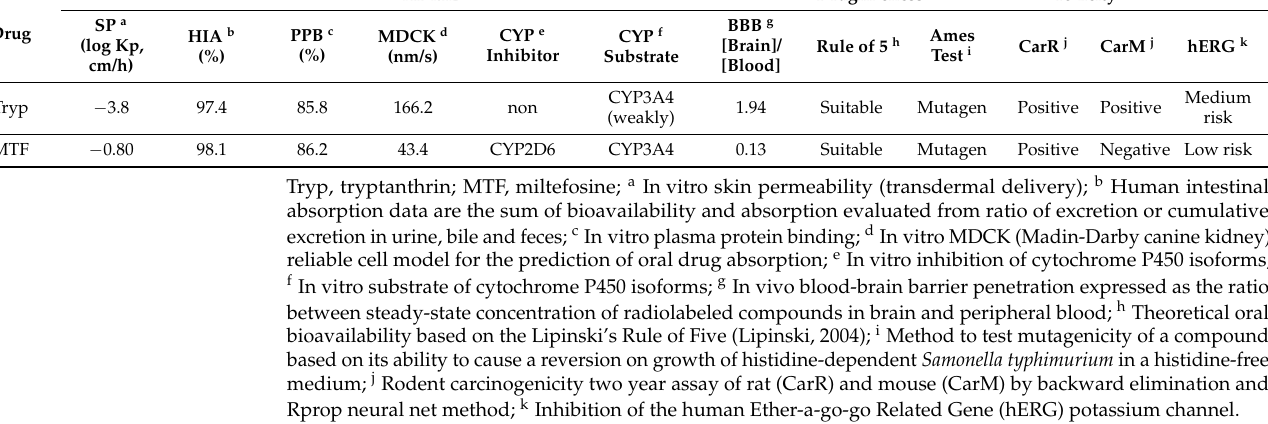
Table 3. In silico predicted pharmacokinetic and toxicological parameters of tryptanthrin and miltefosine. ADME